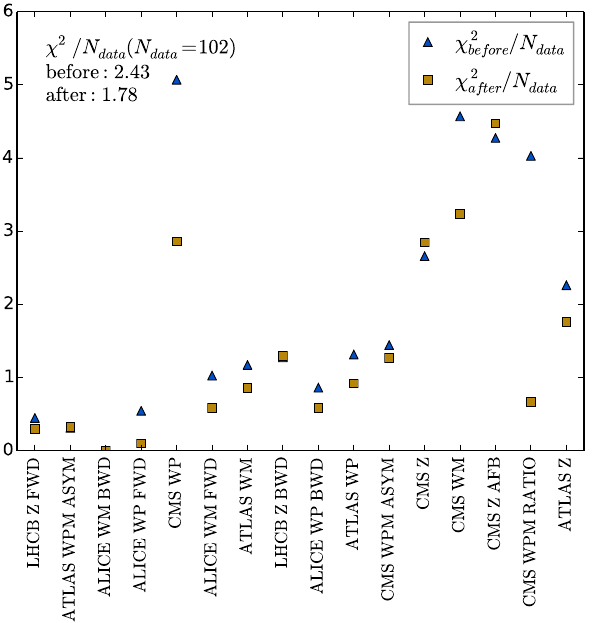
Fig. 23 χ 2 per experiment before and after the reweighting procedure using all LHC pPb data